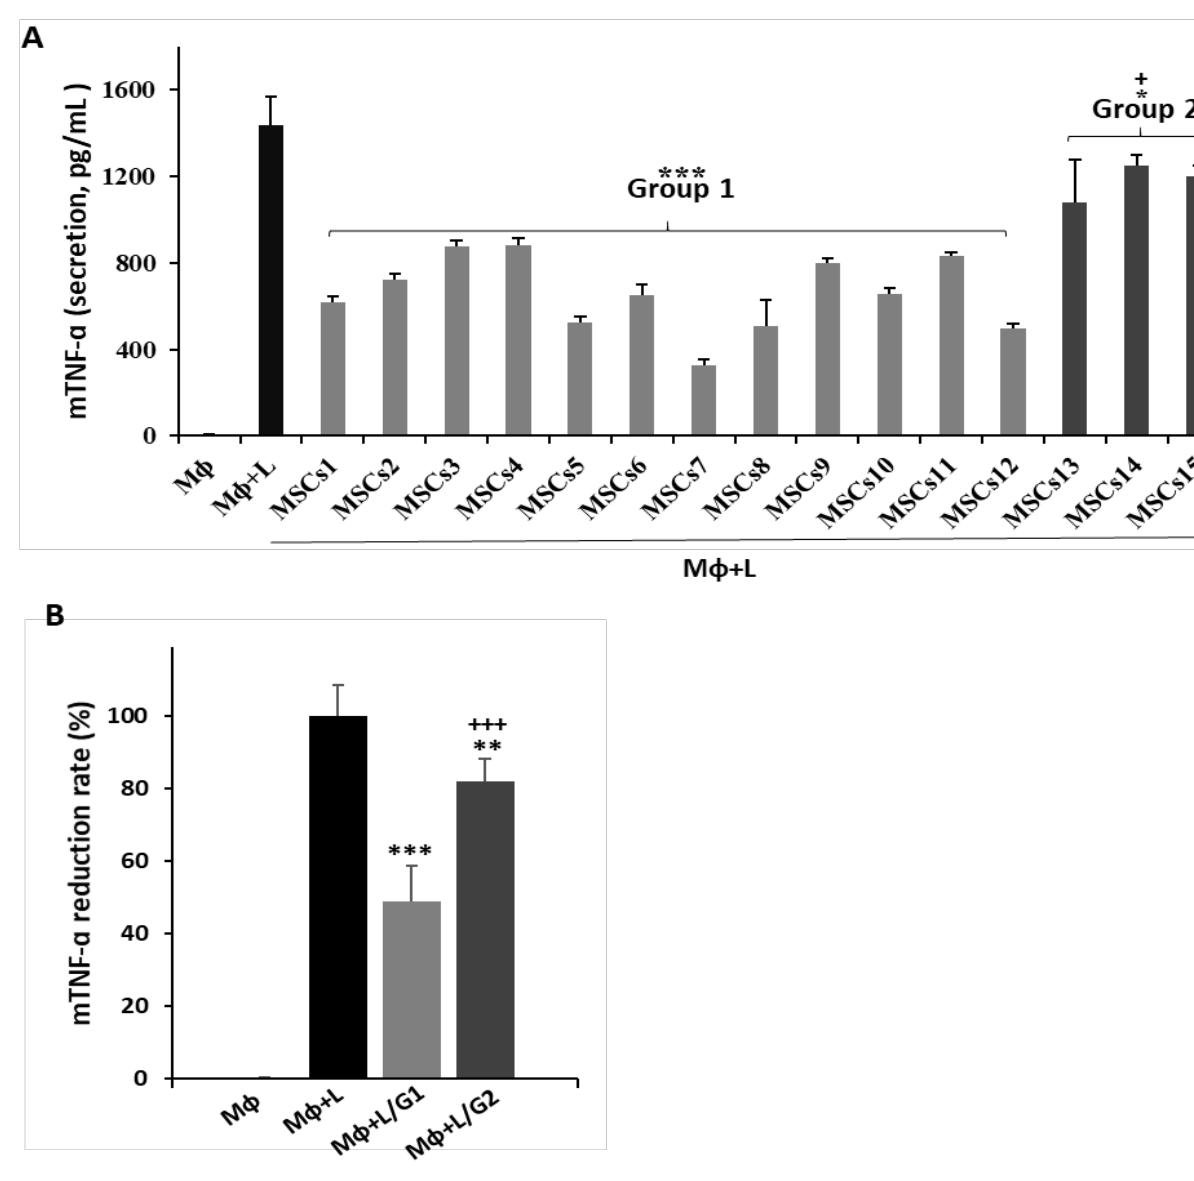
Figure 2. Anti-inflammatory effect of UCB-MSCs in LPS-stimulated macrophages. RAW 264.7 cells were exposed to LPS and co-cultured with UCB-MSCs for 2 days. ( A , B ) Cell supernatants were analyzed for inflammatory cytokine TNF- α levels via ELISA. Fifteen different MSC lots were evaluated, all of which exhibited anti-inflammatory effects. MSCs were divided into two groups based on the extent of TNF- α suppression; namely, Group 1 (MSCs1 to MSCs12) and Group 2 (MSCs13 to MSCs15). ( A ) Error bars represent the means ± SD, n = 5 per group; *** p < 0.001, ** p < 0.01, * p < 0.05 vs. M Φ + L, +++ p < 0.001, + p < 0.05 vs. Group 1. ( B ) Data are presented as the mean ± SD for n = 5 (M Φ , M Φ + L ), n = 60 (M Φ + L /G1), or n = 12 (M Φ + L /G2) per group; *** p < 0.001 vs. M Φ + L , + p < 0.05 vs. M Φ + L /G1. M Φ : macrophage; L: LPS; G1: Group 1; G2: Group 2.